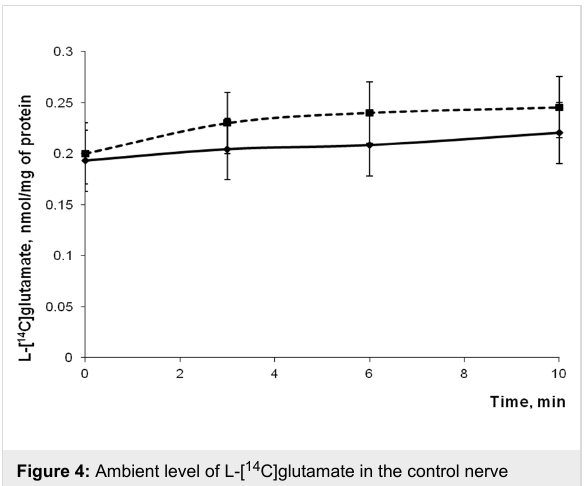
Figure 5: (a) Membrane potential of the synaptosomes after the addi- tion of D-mannose-coated γ -Fe 2 O 3 nanoparticles. The suspension of the synaptosomes was equilibrated with rhodamine 6G (0.5 µM); when the steady level of the dye fluorescence had been reached, nanoparti- cles (250 µg/mL) were added (arrows). (b) Rhodamine 6G fluores- cence after the addition of D-mannose-coated γ -Fe 2 O 3 nanoparticles (without synaptosomes). Each trace represents four experiments performed with different